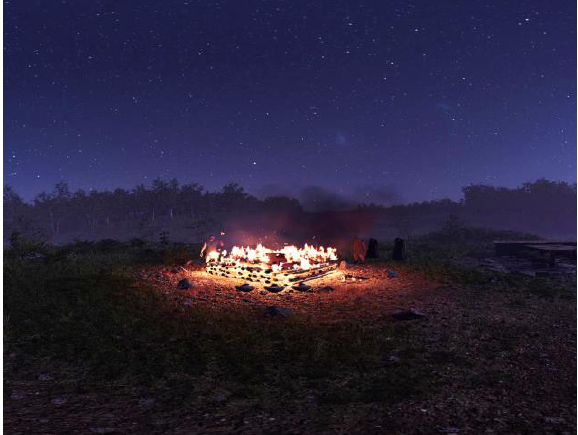
Figure 6: A still frame from the VR animation of the